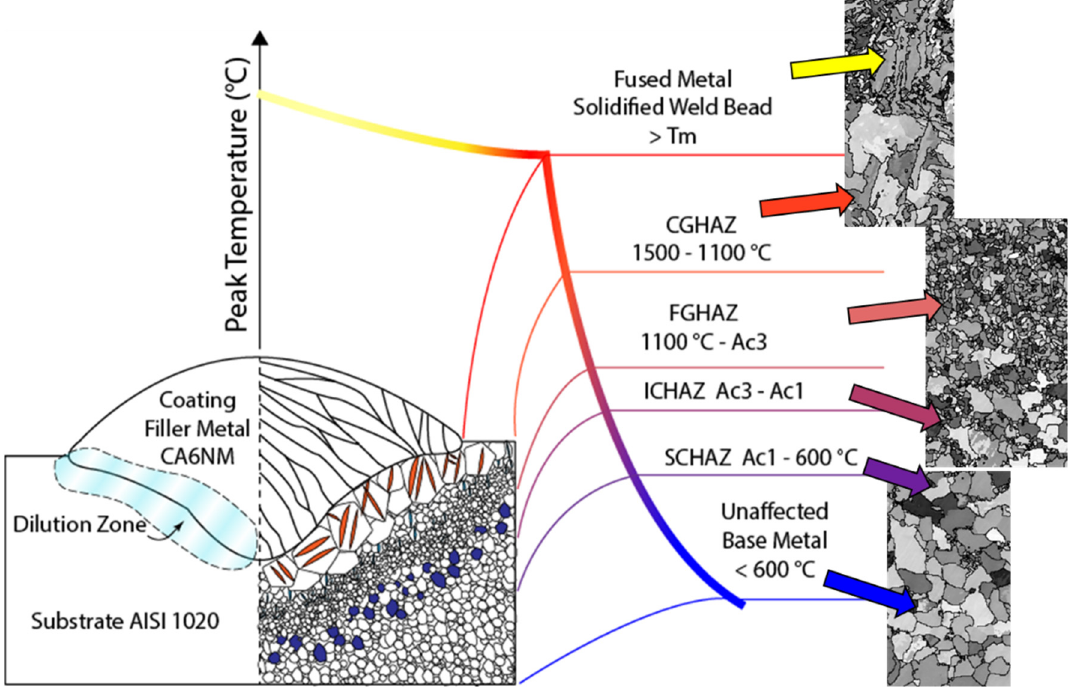
Figure 17. Schematic representation of welded microstructures and their metallurgical zones, divided according to the peak temperature. Images of the generated microstructure are displayed accordingly.